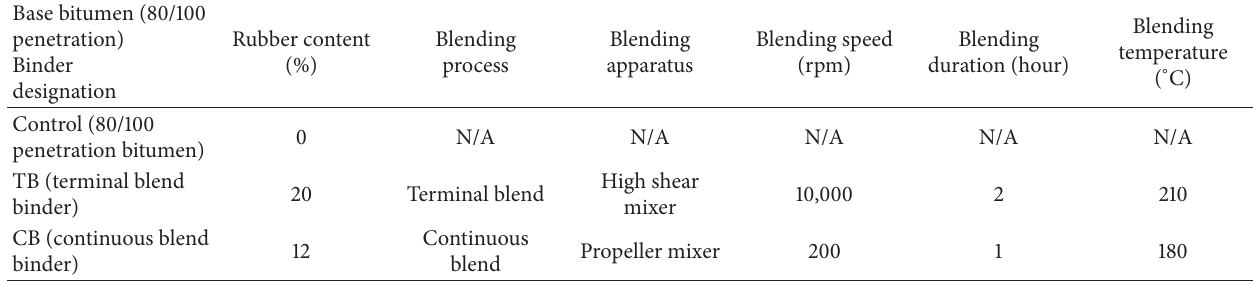
Table 4: Binder features.